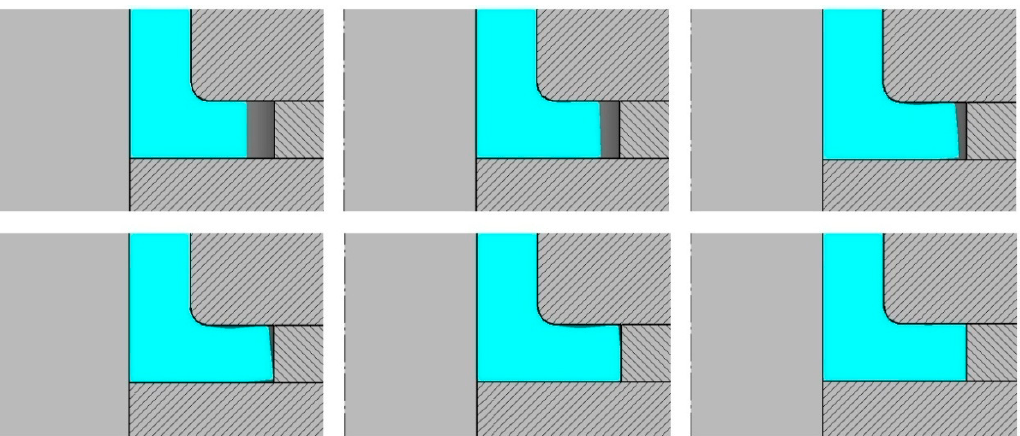
Figure 3. Scheme illustrating die cavity filling in the incremental radial extrusion of the flange.